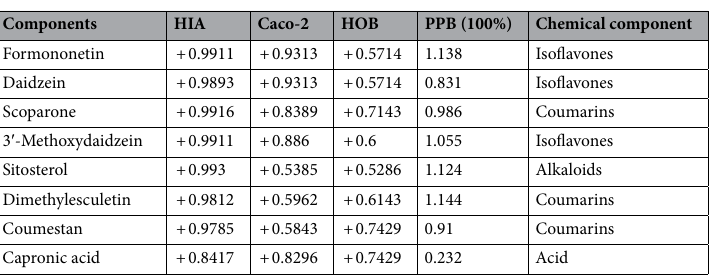
Table 1. Partial ADME values and chemical component of the 9 post-screening